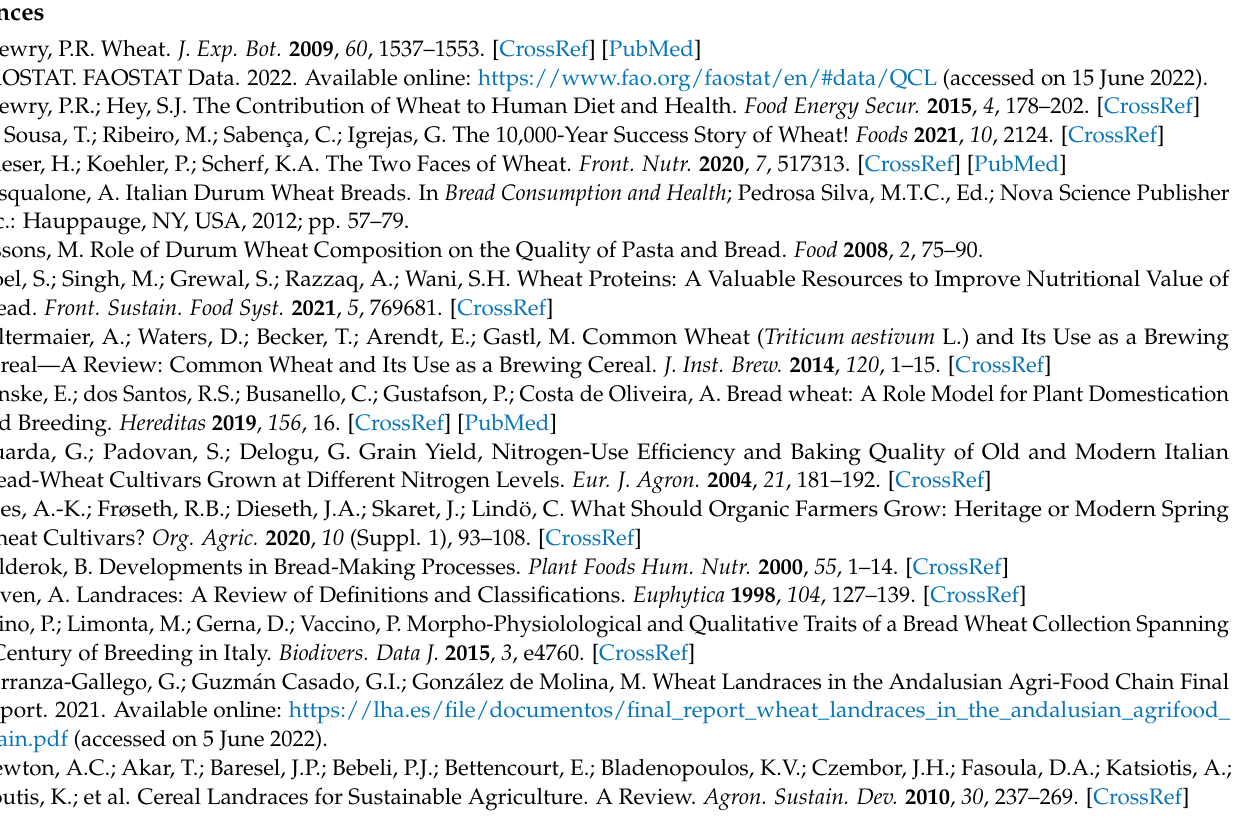
Table S2: Crust colour characteristics, Table S3: Full list of R packages for data analysis and visualiza- tion; Table S4: Details on principal components and variance; Figure S1: Contribution of variables to PC1 and PC2; Figure S2: Representation of the different breads obtained using the flours from the varieties under study in the two